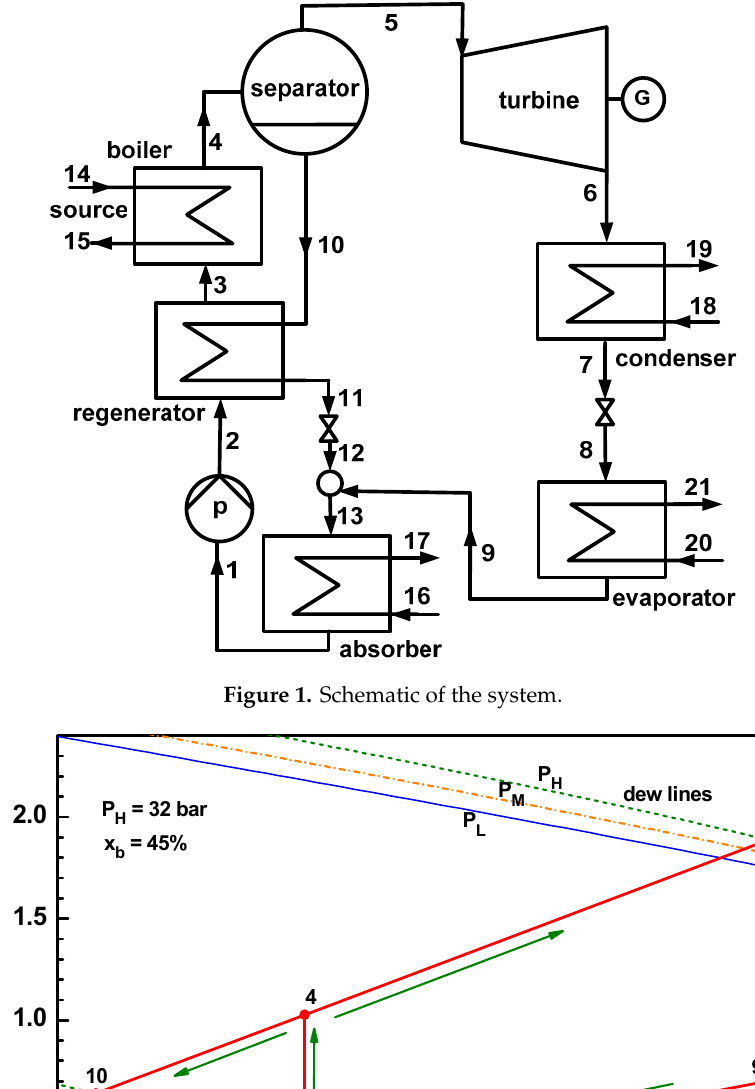
Figure 2 . Enthalpy-ammonia fraction diagram of the system. Figure 2. Enthalpy-ammonia fraction diagram of the